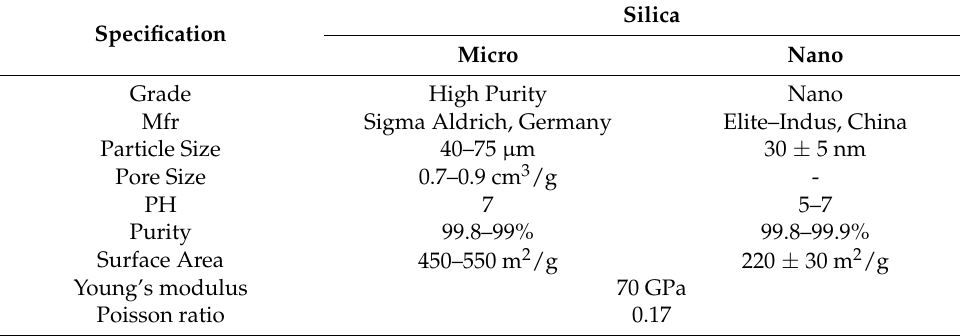
Table 1. Properties of Micro and Nano Silica